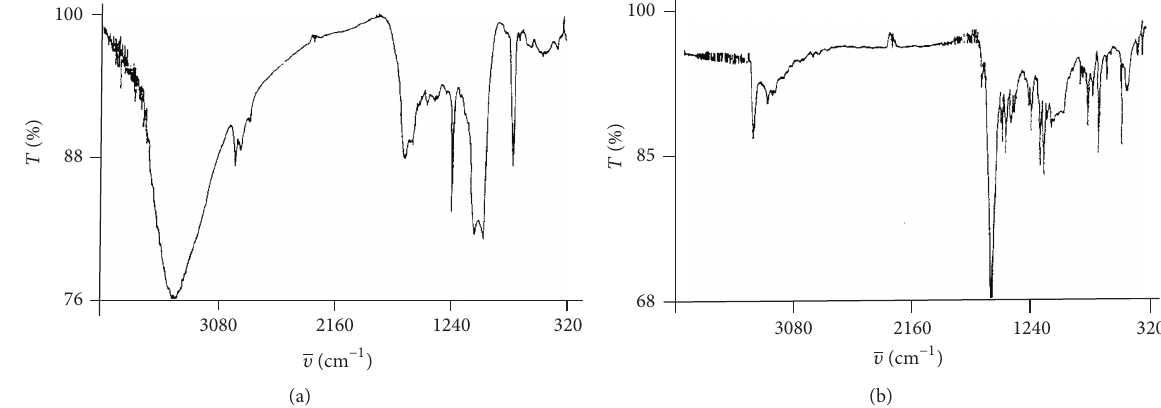
F 2: IR spectra of (a) electrochemically prepared POAP and (b) 3-aminophenoxazone